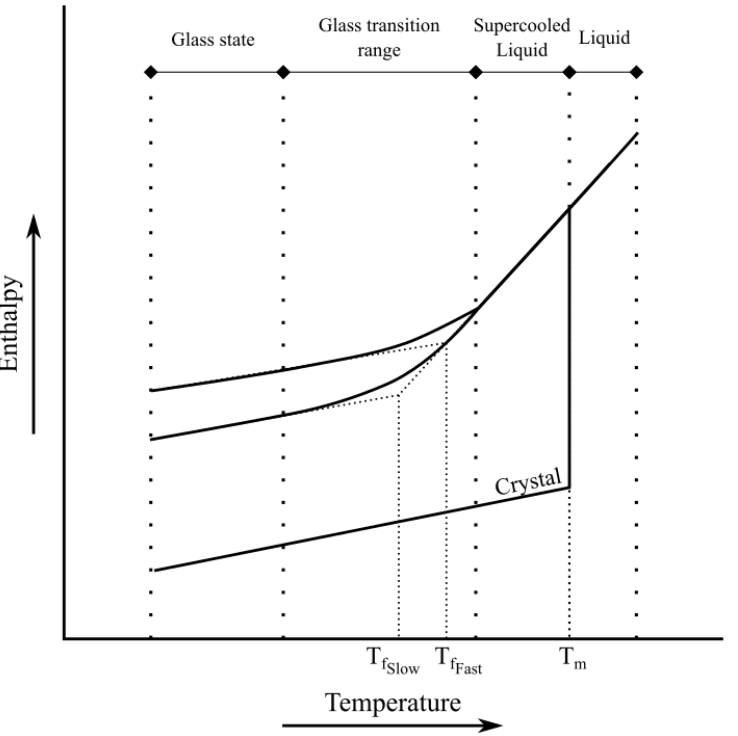
Figure 2. Glass transition